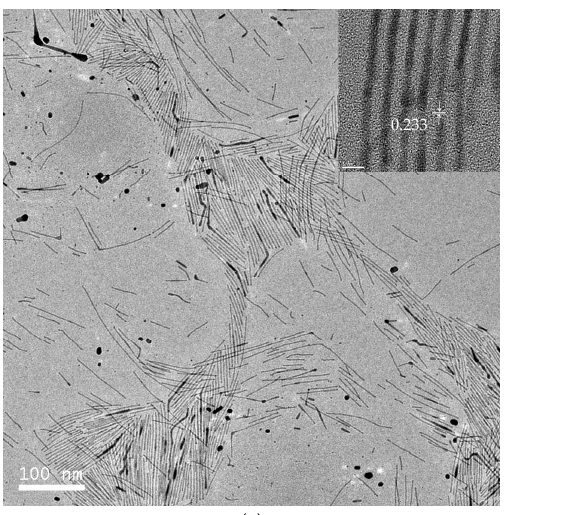
Figure 1. Transmission electron microscope (TEM) and high resolution transmission electron microscope (HRTEM ) images of gold round nanodots ( a ); short nanobars ( b ); long nanorods ( c ); and silk-like ultralong and ultrathin nanowires ( d ) prepared at [TPS]:[Au]:[OA]:[OAm] = 3:1:0.8:3.8, 3:1:48:45.6, 3:1:24:45.6, and 3:1:24:114, respectively.